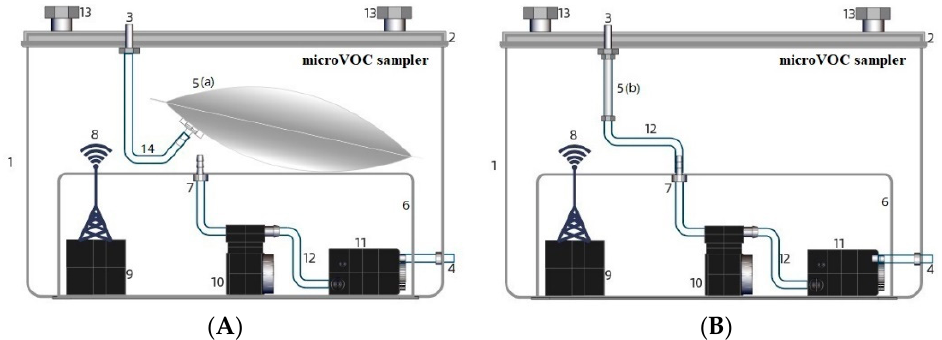
Figure 2. Schematic diagram of microVOC sampler (1: Polyethylene sealed box; 2: Polyethylene box